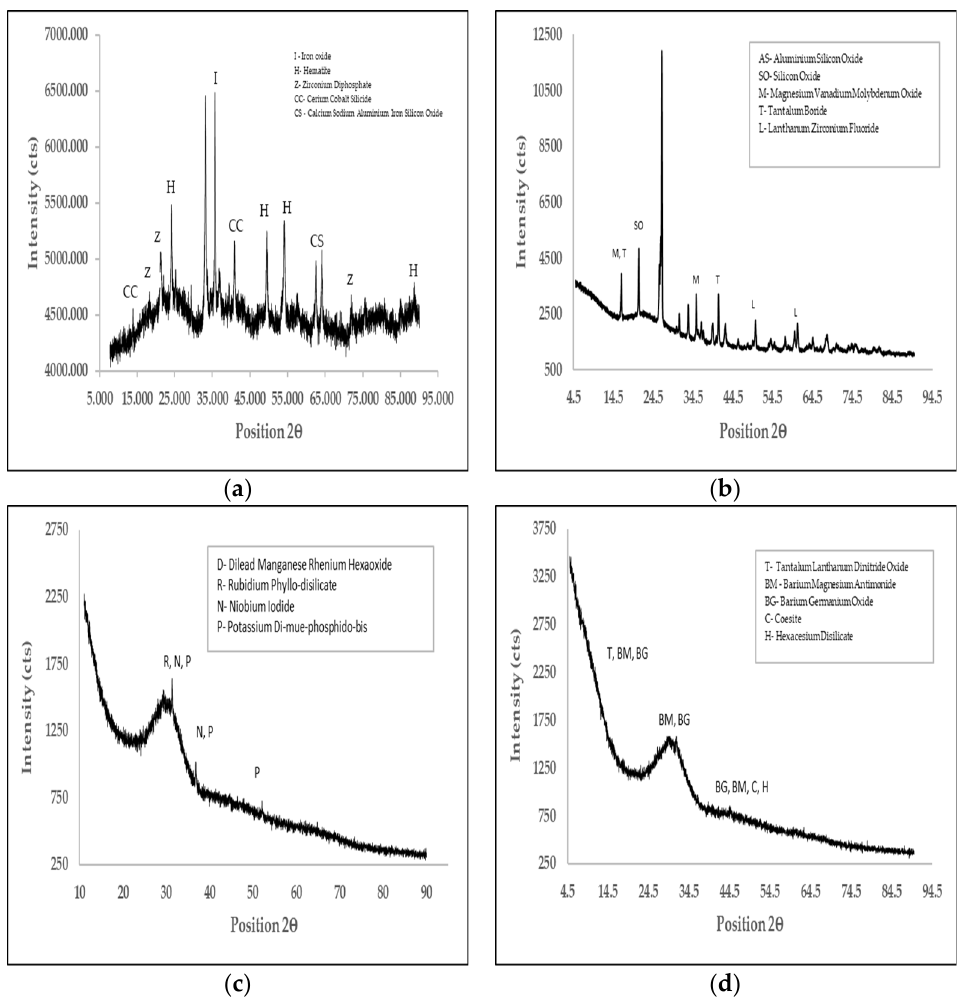
Figure 6. ( a ) X-ray diffraction pattern of red mud sample. ( b ) X-ray diffraction pattern of fly ash sample. ( c ) X-ray diffraction pattern of ground granulated blast furnace slag sample. ( d ) X-ray diffraction pattern of alccofine sample.